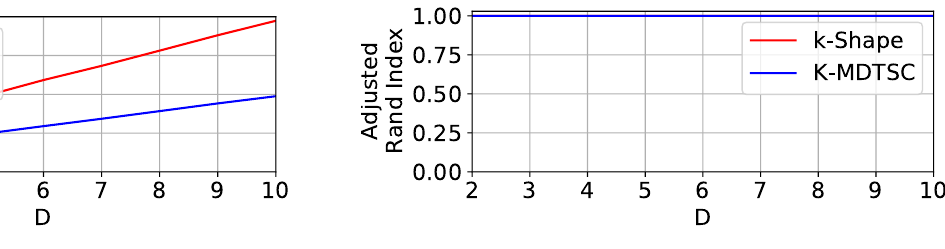
Figure 5. Number of dimensions D